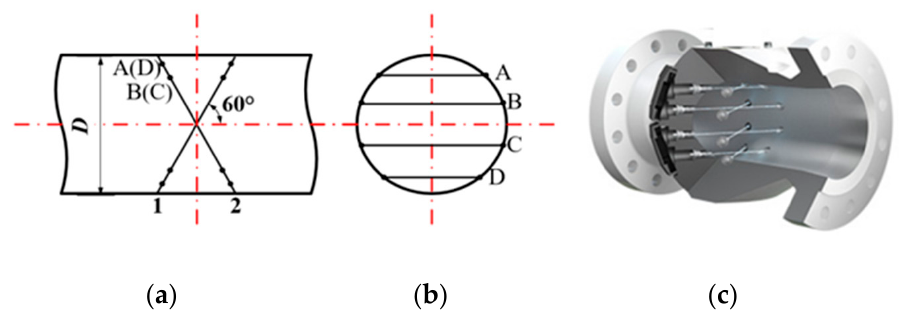
Figure 2. Schematic of a 2-section/8-path TM-USM ( a ) top view, ( b ) side view, ( c ) stereo schematic. The path position was arranged according to the Gauss–Jacobi integration scheme, as shown in Table 1 [35]. The average surface velocity was the weighted sum of the velocities along the individual paths. For a single measurement section, there were: